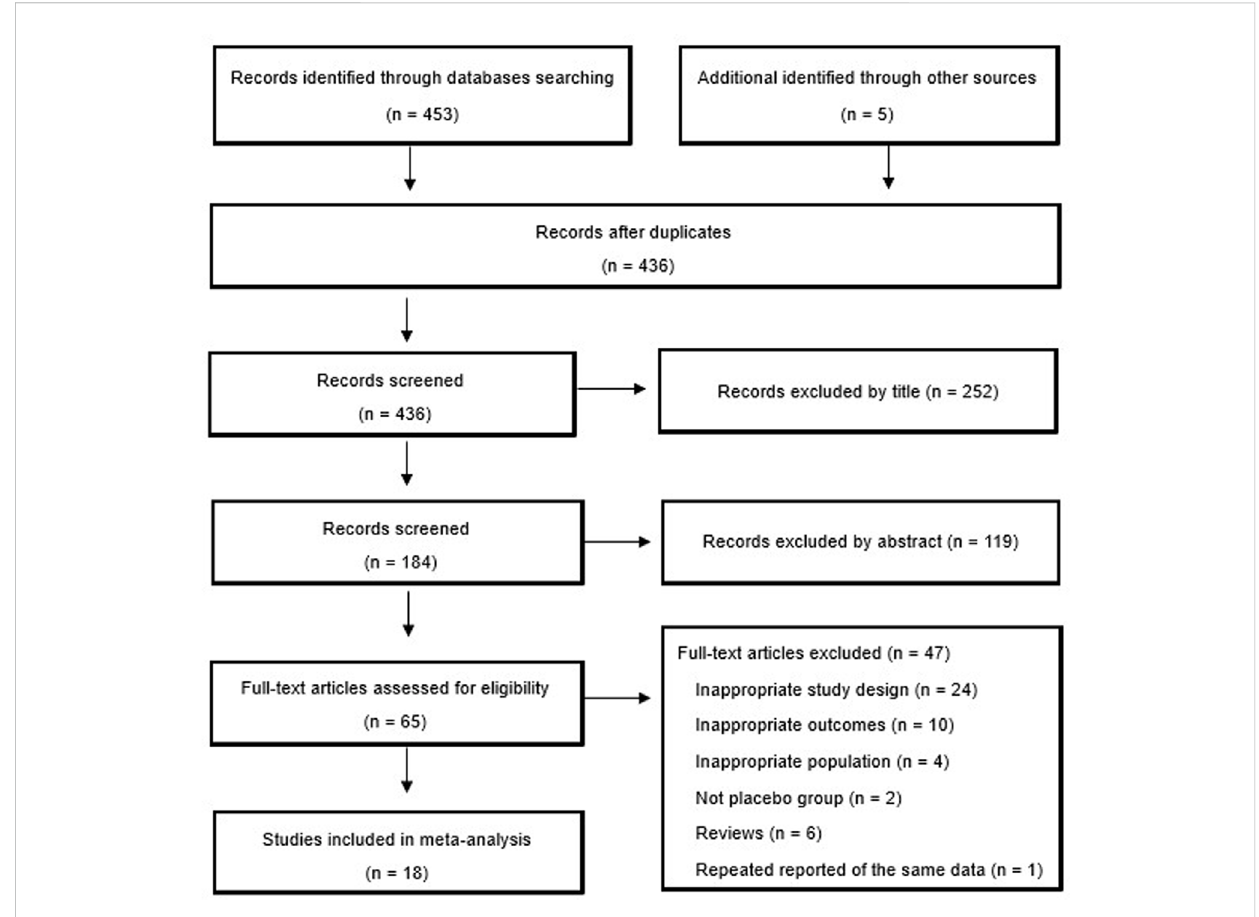
FIGURE 1 Study selection process for the meta-analysis with speci fi cations of